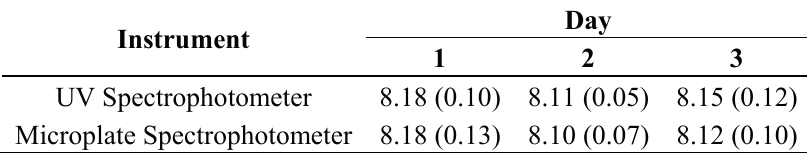
Table 2. Interday repeatability of the pK a value.